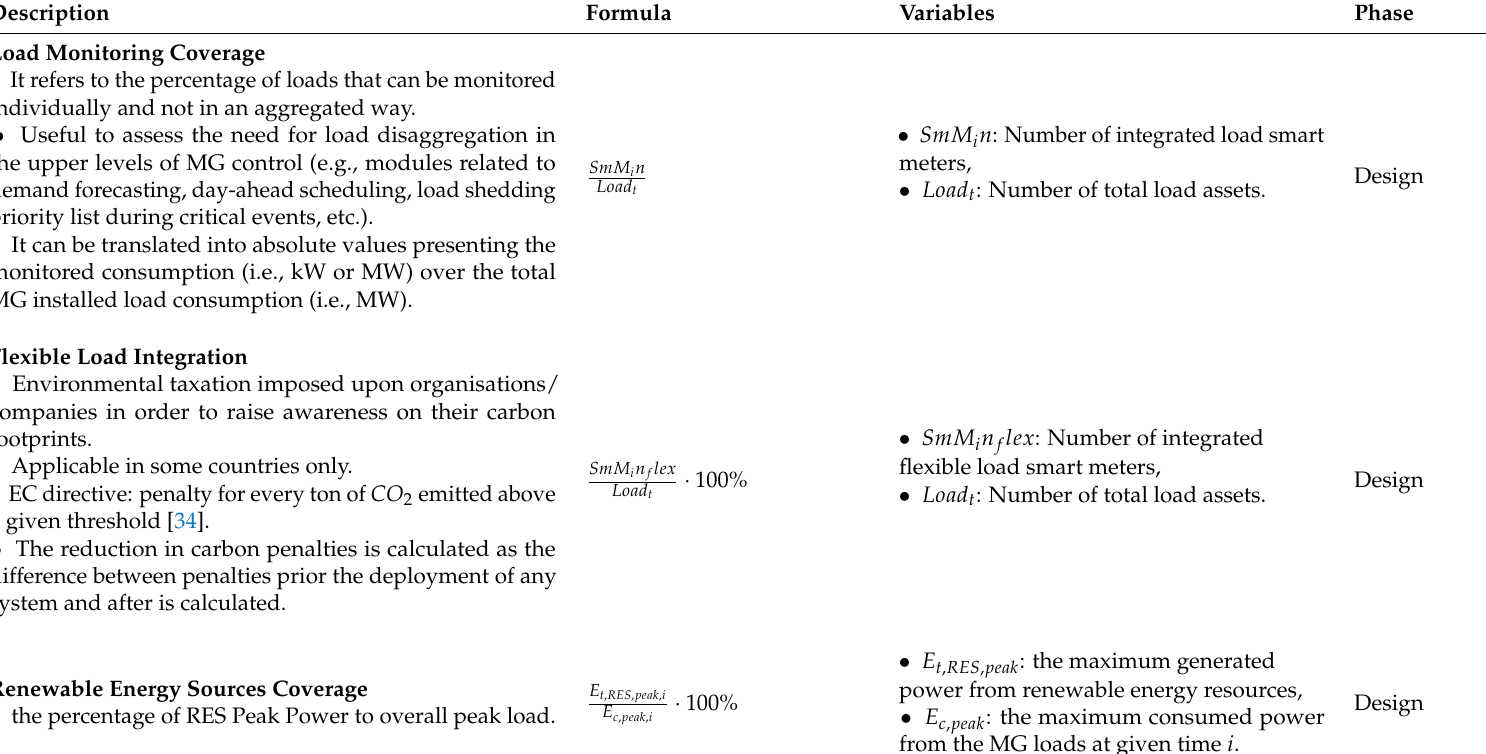
Table A3. Detailed Representation of MG Reliability